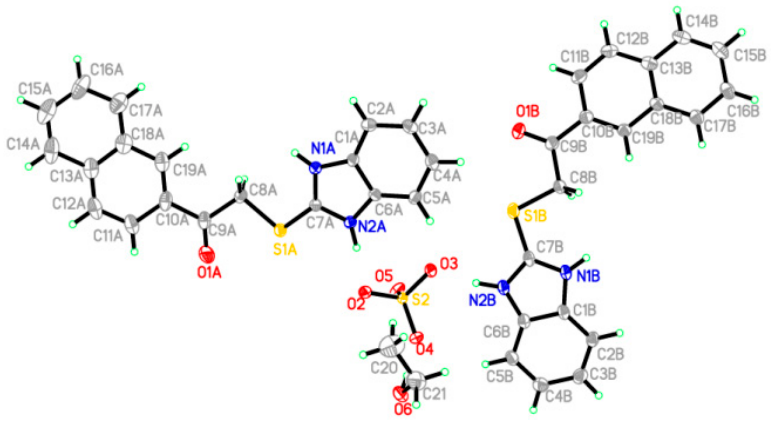
Figure 3. An ORTEP diagram of the final X-ray structure of compound 4u .